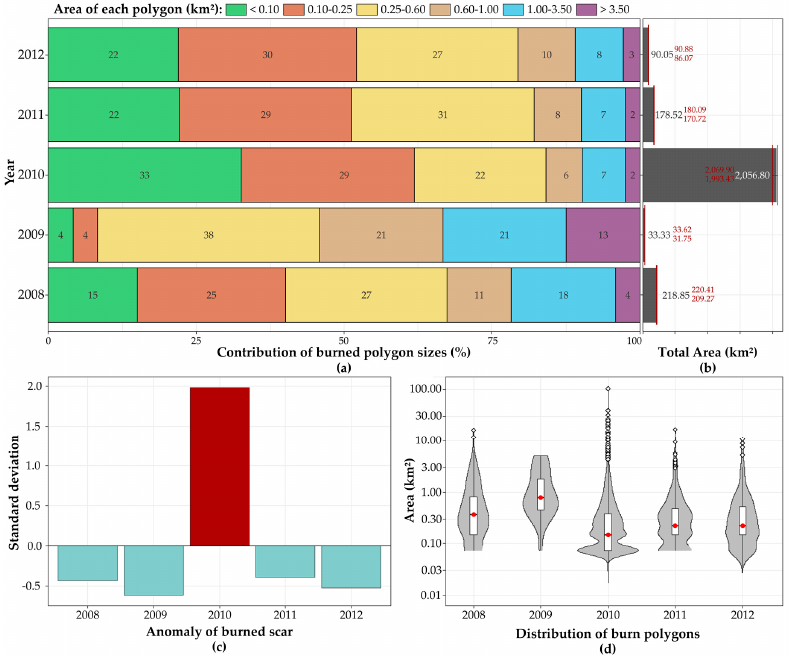
Figure 3. Evaluation of the annual burned area time series from 2008 to 2012. ( a ) Contribution of each burned polygon size to the total burned area; ( b ) total burned area (ha) with upper and lower limits; ( c ) anomaly of number of burned scars, normalized by its standard deviation ( σ ) for the 2008–2012 period; ( d ) Distribution of burn polygon sizes, where the sides of each violin is a kernel density function; the red dot represents the median; the white bar indicates the interquartile range; the straight vertical line represents the 95% confidence interval; and the white dots represent outlier polygons.